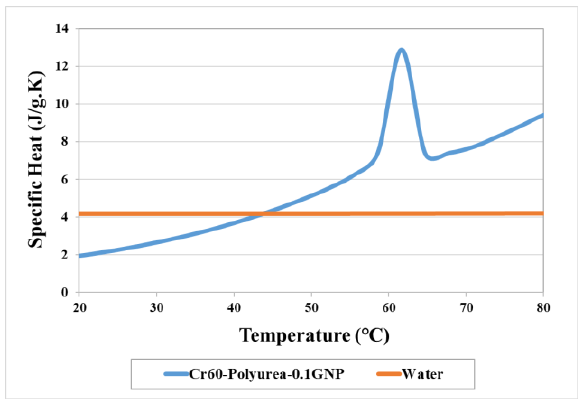
Figure 11. Specific heat of Cr60@polyurea-0.1%GNP slurry (16 wt%) and water [30] .